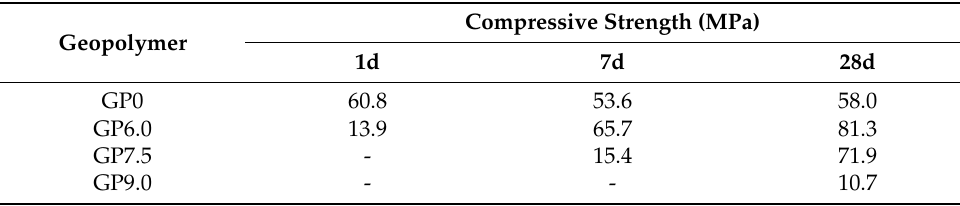
Table 4. Compressive strength of geopolymers after 1, 7 and 28 days of curing (1d, 7d, 28d).